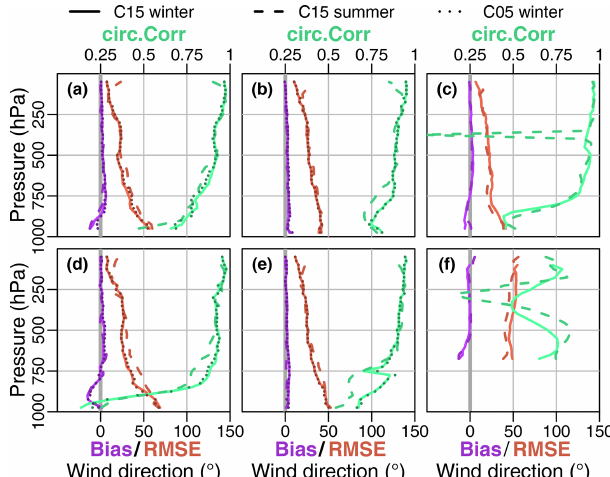
Figure 14. Like Fig. 12 but for wind